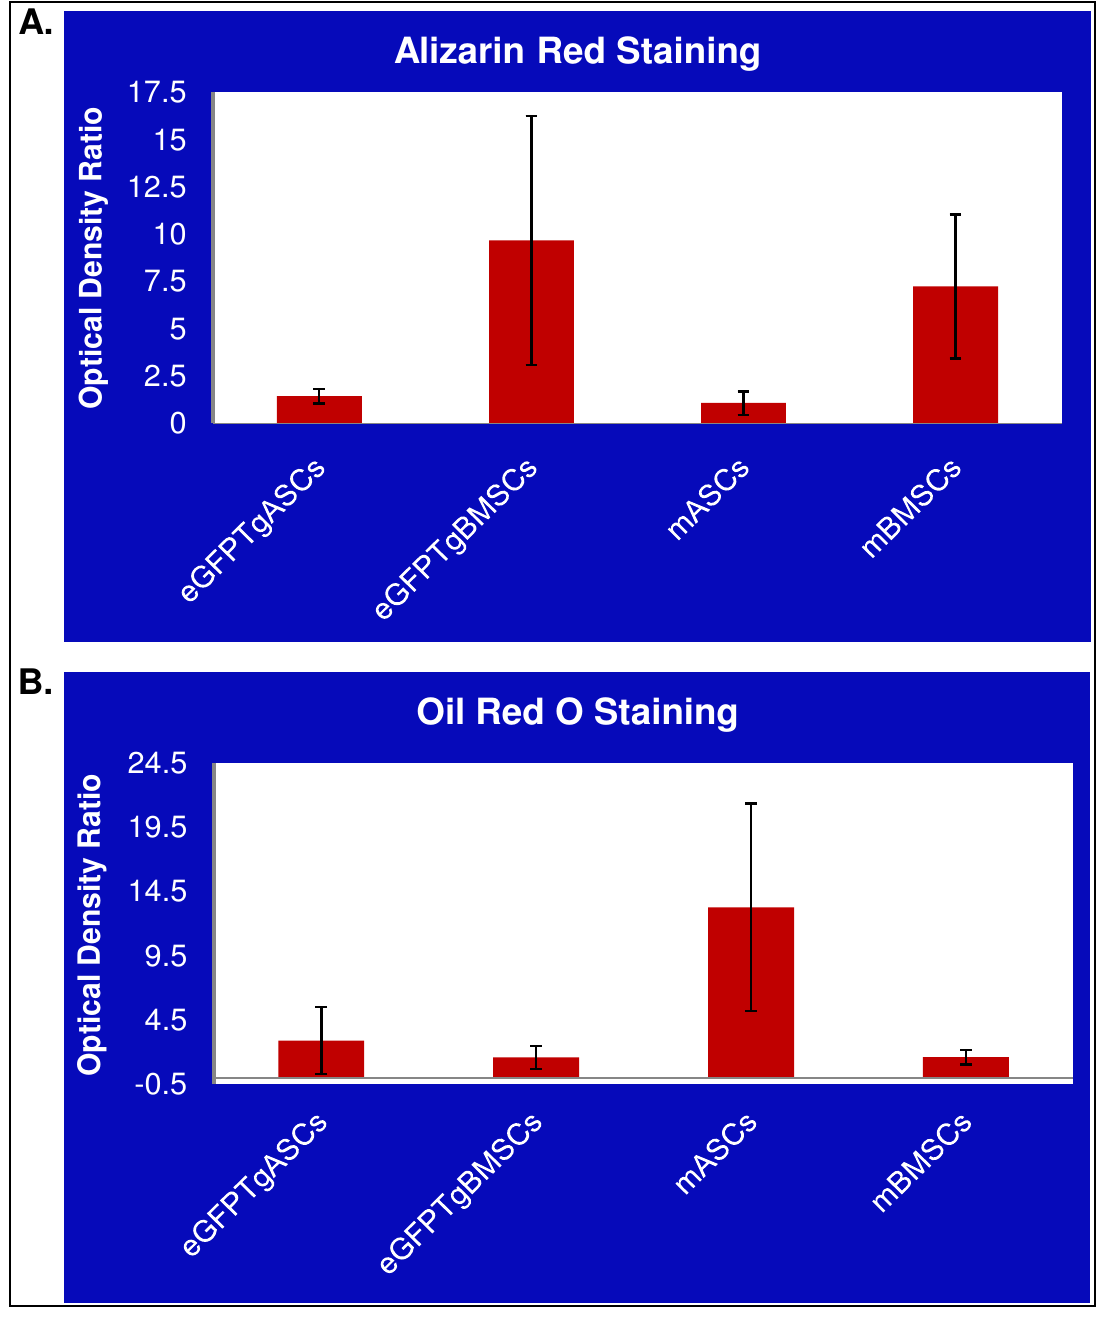
Figure 3 Quantitative differentiation of mMSCs and GFPTgMSCs along osteogenic and adipogenic lineages . A. Cells were incubated in CEM and then transferred to osteogenic media for 14 days. The cells were then stained with Alizarin Red and de-stained with 10% cetylpyridinium chloride. Optical density (OD) was measured at 560 nm and normalized to protein content. Graphs represent the ratio of normalized OD of differentiated cells and normalized OD of control cells. B. Cells were incubated in CEM and then transferred to adipogenic media for 14 days. The cells were then stained with Oil Red O and de- stained with isopropanol. OD was measured at 520 nm and normalized to protein content. Graphs represent the ratio of nor- malized OD of differentiated cells and normalized OD of control